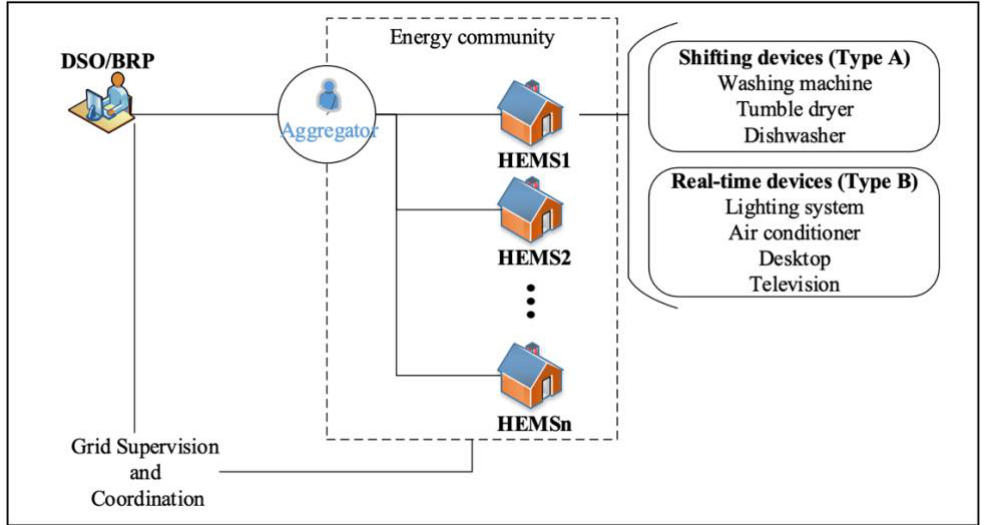
Fig. 1: Overview of flexibility management of DR devices [19] Figure 1. Overview of flexibility management of DR devices